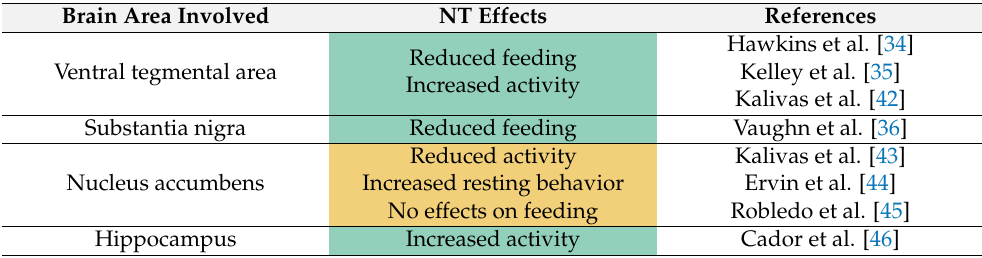
Table 1. Experimental NT injection and major central metabolic responses. A green color indicates favorable effects on metabolism, while effects that negatively impact on metabolism are marked with an orange background. Data are from rat